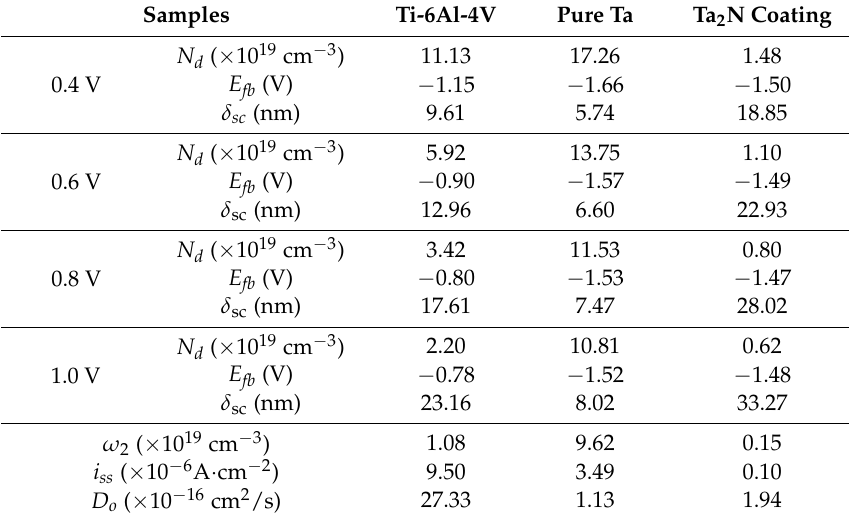
Table 3. Summary of parameters derived from capacitance measurements and PDM analysis for the passive films formed on the investigated specimens in Ringer’s physiological